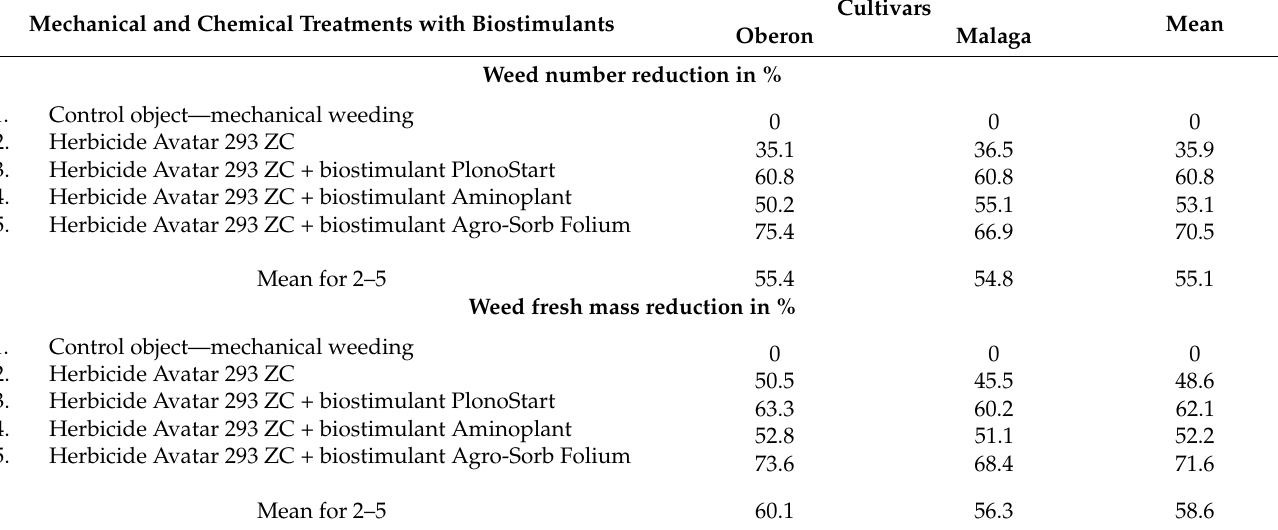
Table 4. Weed number reduction (%) in relation to the control object before the potato tubers harvest (mean for years